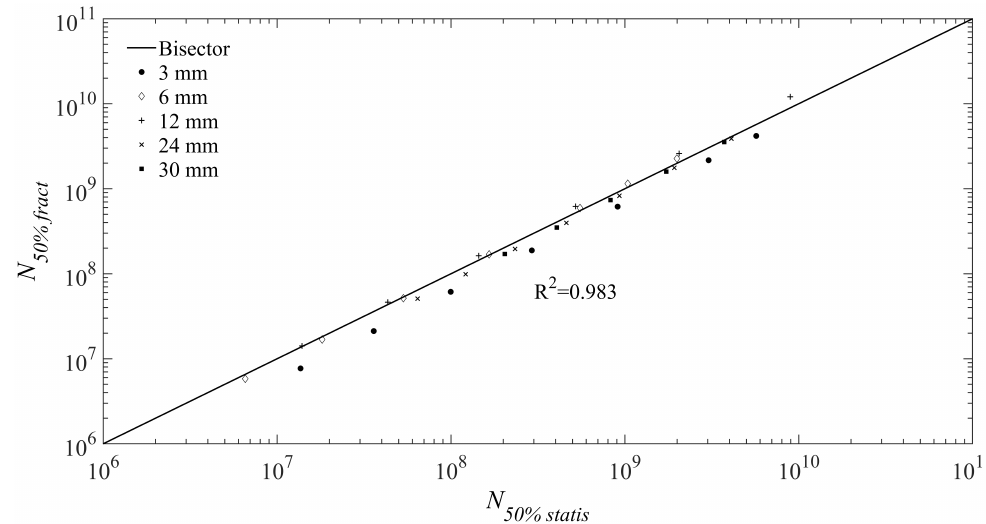
Figure 10. Median fatigue life predicted by the fractal model ( N 50% fract ) versus the statistical model ( N 50% statis